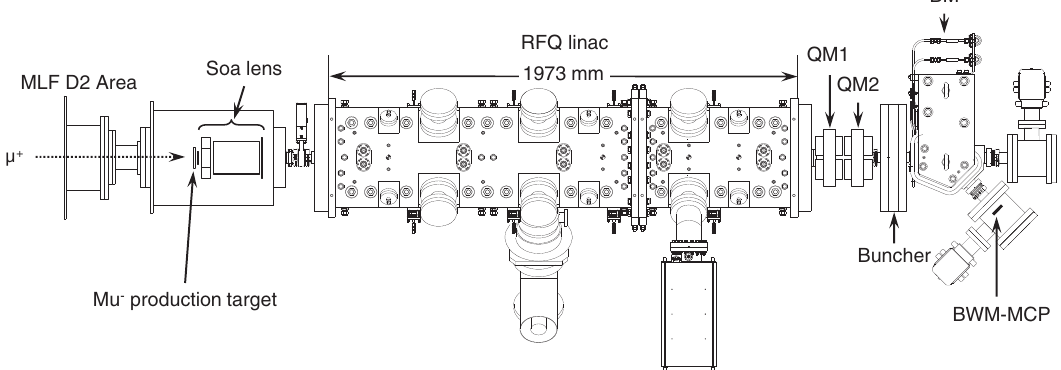
FIG. 5. Drawing of the apparatus to produce Mu − bunches installed in the MLF MUSE D2 area at the J-PARC.